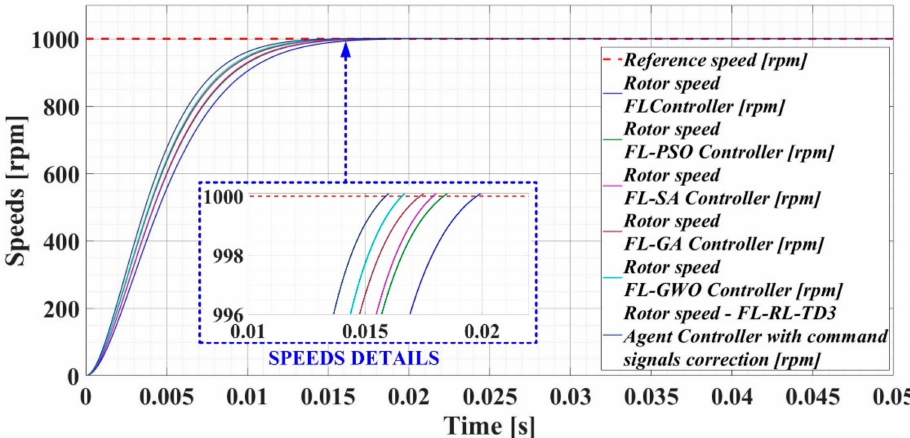
Figure 16. Comparison of the time evolution of speed for PMSM–CS–CI based on the FL-type